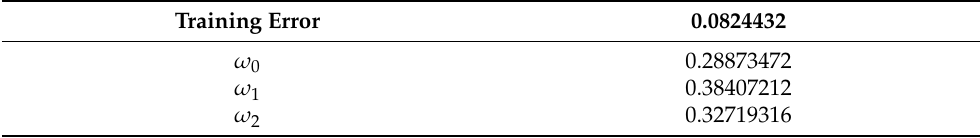
Table 6. Obtained weights from the training phase and the training error setting gradient to 0.